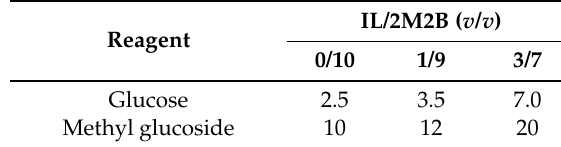
Table 2. Solubility (mg/mL) of glucose and methyl glucoside in [HMIm][TfO]/2M2B mixtures at room temperature (~25 °C) a .